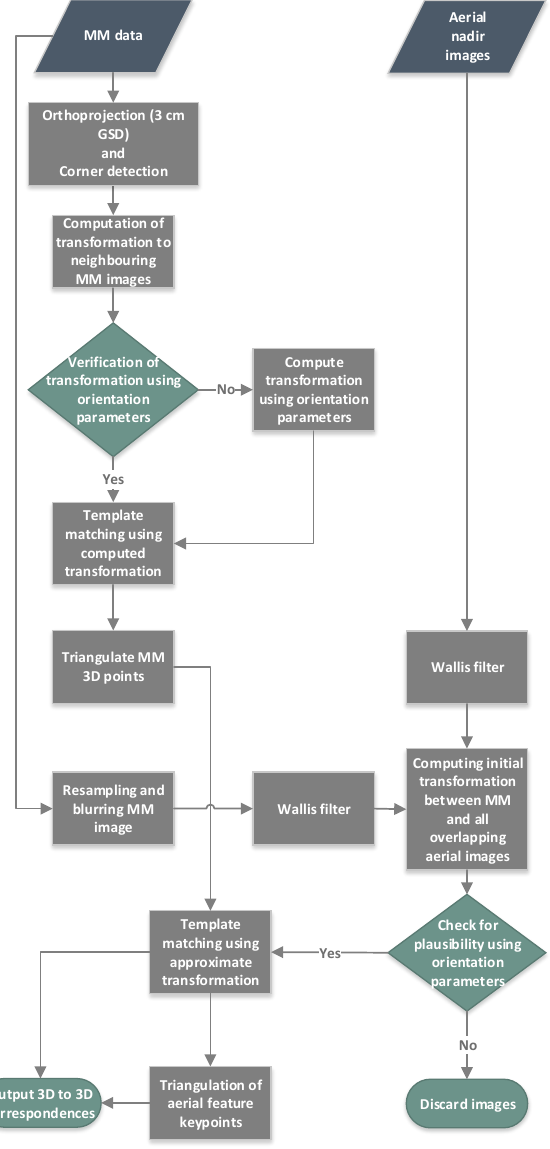
Figure 1. Complete workflow for the registration of Mobile Mapping and aerial nadir